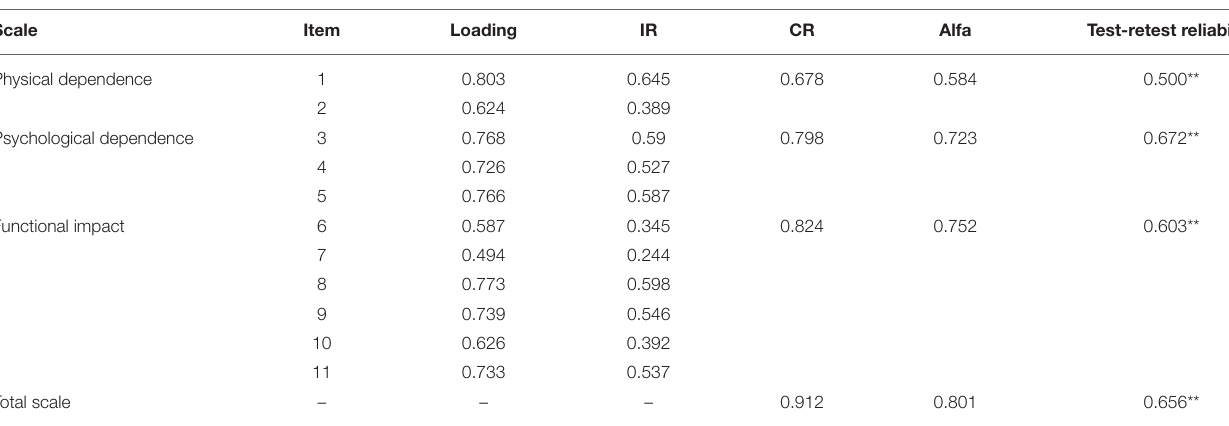
TABLE 3 | Internal reliability and test-retest reliability of the SDDS.